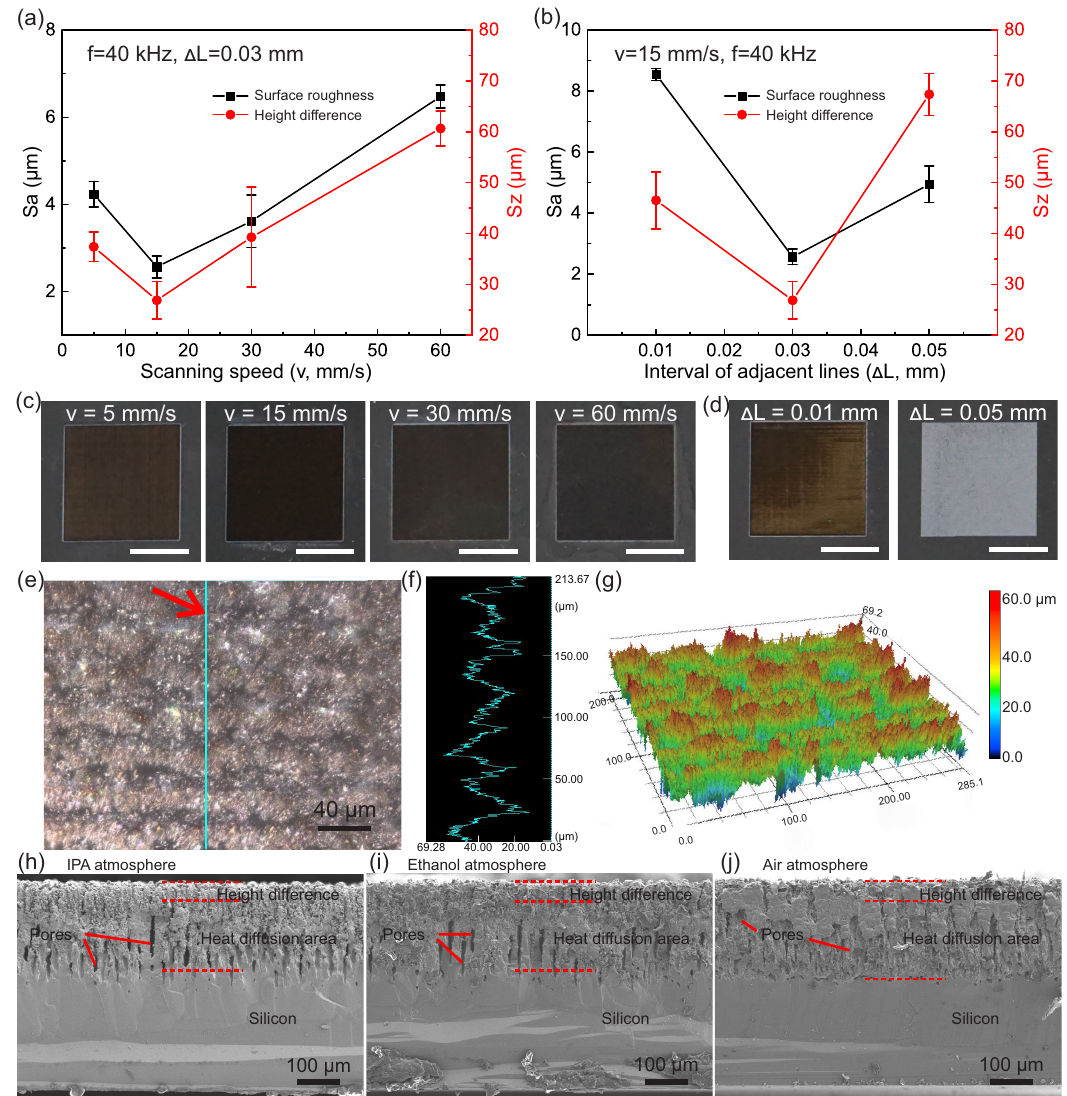
Figure 3. Surface morphology versus UV ‐ laser operating parameters. ( a , b ) Surface roughness (Sa) and height difference (Sz) of surface texture of the UV ‐ laser ‐ treated Si with different scanning speeds (5, 15, 30, and 60 mm/s) ( a ) and different intervals of adjacent scanning lines (0.01, 0.03, and 0.05 mm) ( b ). ( c , d ) Corresponding optical photos, scale bars indicate 5 mm. ( e ) The magnified planar view of a 285 × 200 μ m 2 area of black Si with v = 15 mm/s and Δ L = 0.03 mm in an IPA atmosphere. ( f ) The corresponding surface profile of the green line in ( e ). ( g ) The corresponding 3D surface topography observed under the laser scanning confocal microscope. ( h – j ) Cross section view of black Si ( v = 15 mm/s and Δ L = 0.03 mm) treated in the IPA ( h ), ethanol ( i ), and air ( j ) atmospheres observed under FSEM.